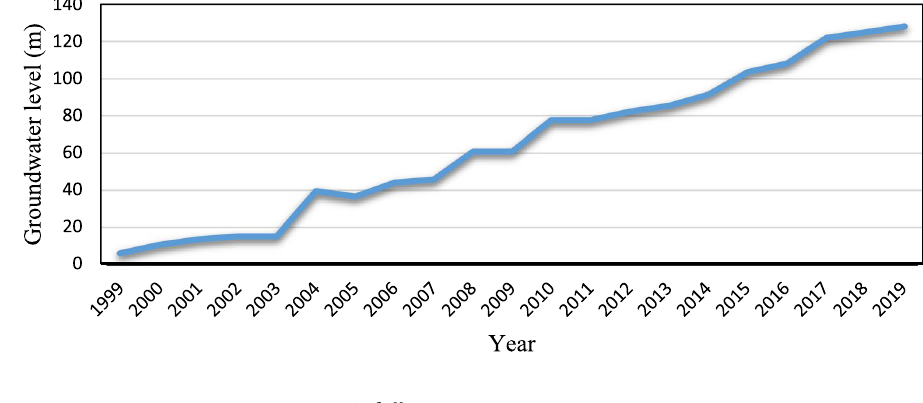
Fig. 17 Groundwater level of the last 20